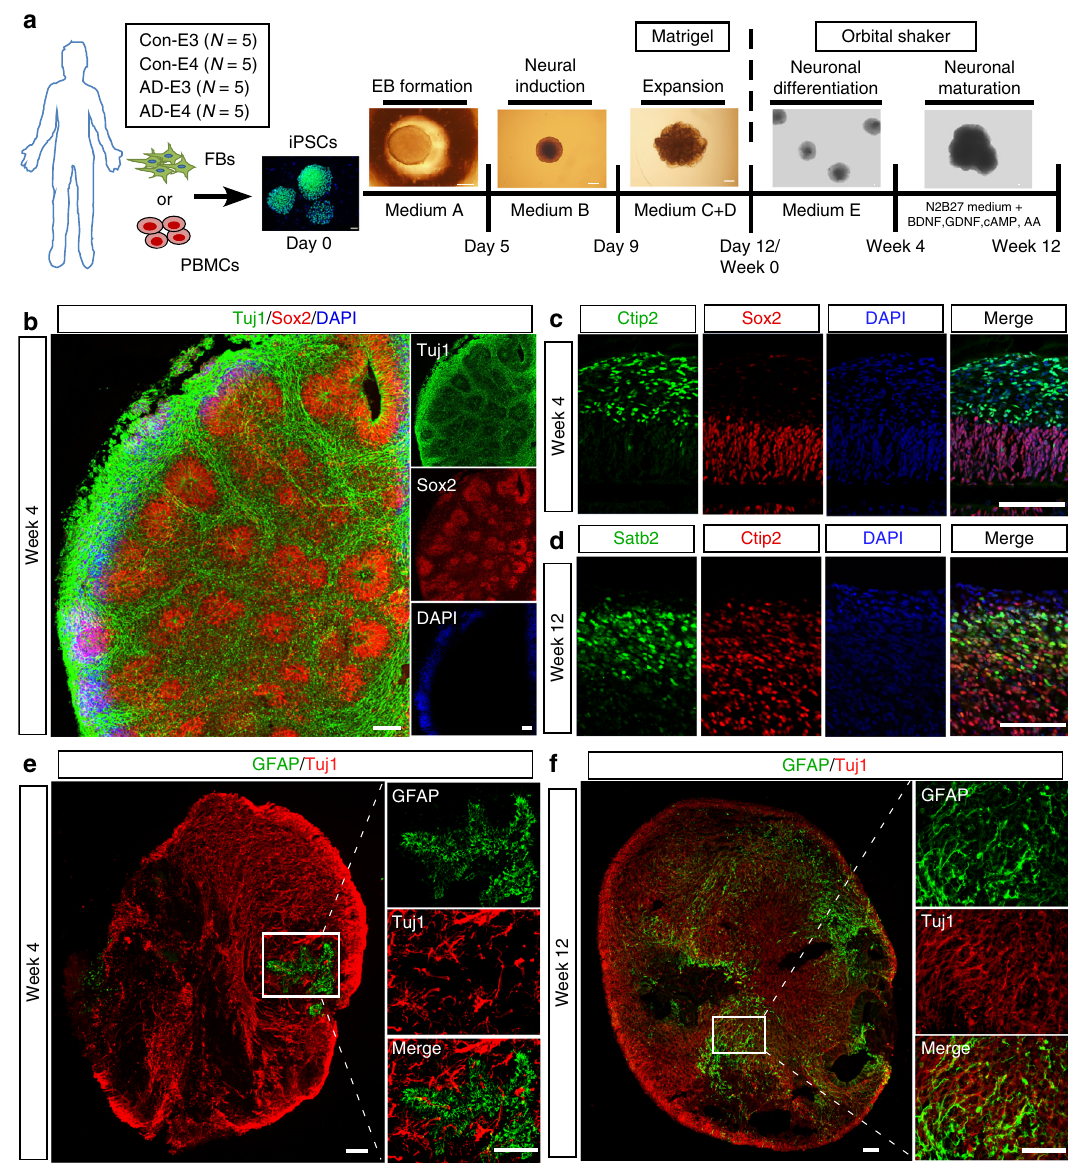
Fig. 1 Generation and characterization of cerebral organoids from human iPSCs. a A schematic overview of the procedures for generating cerebral organoids from human iPSCs using the STEMdiff ™ Cerebral Organoid Kit. b Representative images of the ventricular zone (VZ)-like structure formed by new-born neurons (Tuj1, green) and neural progenitor cells (Sox2, red) in cerebral organoids at week 4 of differentiation. c , d Confocal images showed the cortical layer structure formation when immunostained for Ctip2 (deep cortical layer marker) and Satb2 (super fi cial cortical layer marker) at week 4 ( c ) and 12 ( d ), respectively. e , f Proliferation and migration of astrocytes within cerebral organoids; the differentiation pattern of astrocytes in organoids were monitored by GFAP immunostaining (astrocytic marker) at week 4 ( e ) and 12 ( f ), respectively. Scale bar: 100 μ